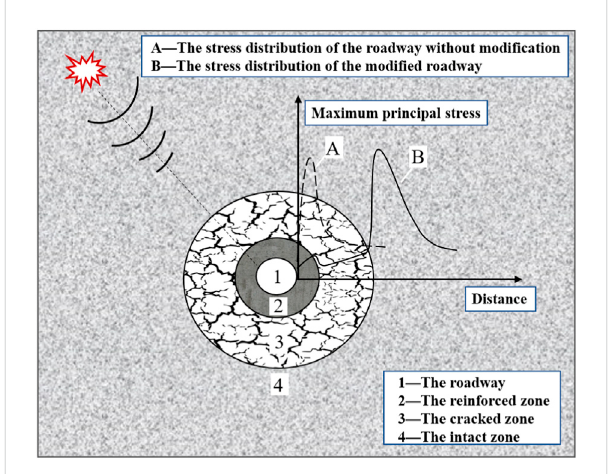
FIGURE 1 The surrounding rock structure of the modi fi ed roadway with in- situ modi fi cation